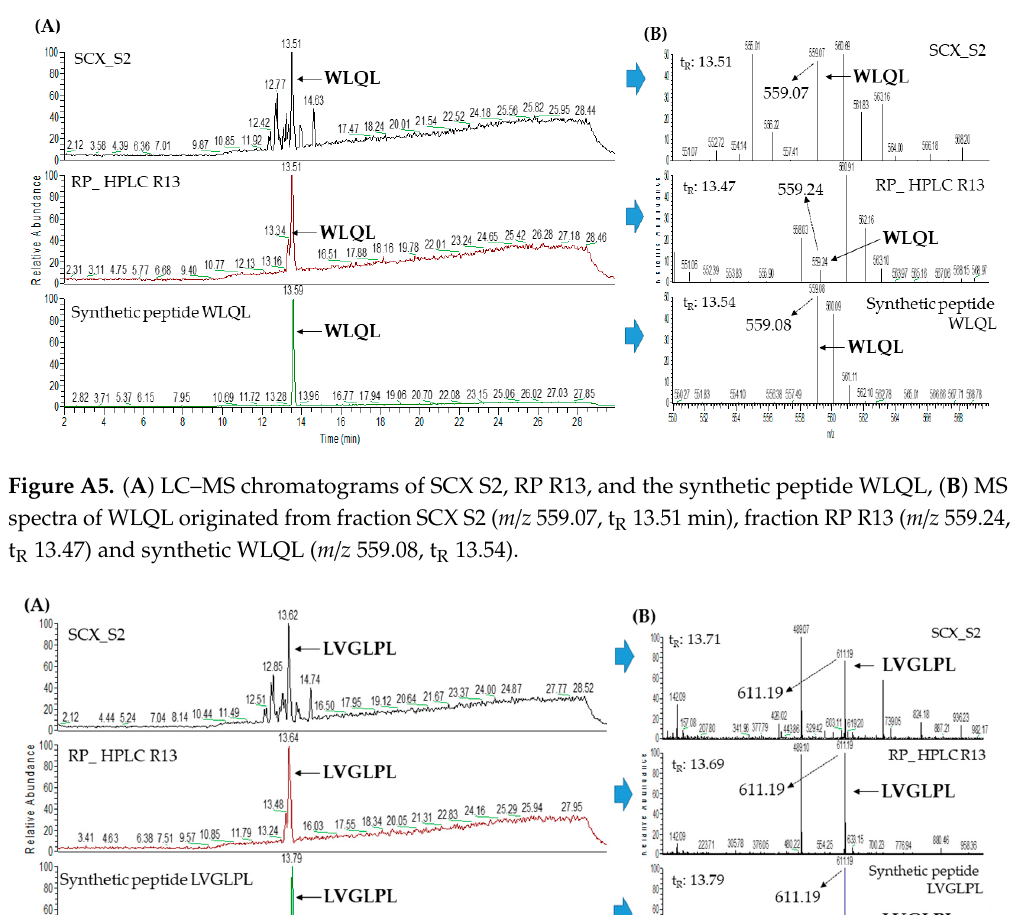
Figure A7. ( A ) LC–MS chromatograms of SCX S2, RP R7, and the synthetic peptide LPSW, ( B ) MS spectra of LPSW originated from fraction SCX S2 ( m / z 502.04, t R 12.63 min), fraction RP R7 ( m / z 502.06, t R 12.61) and synthetic LPSW ( m / z 502.06, t R 12.65).